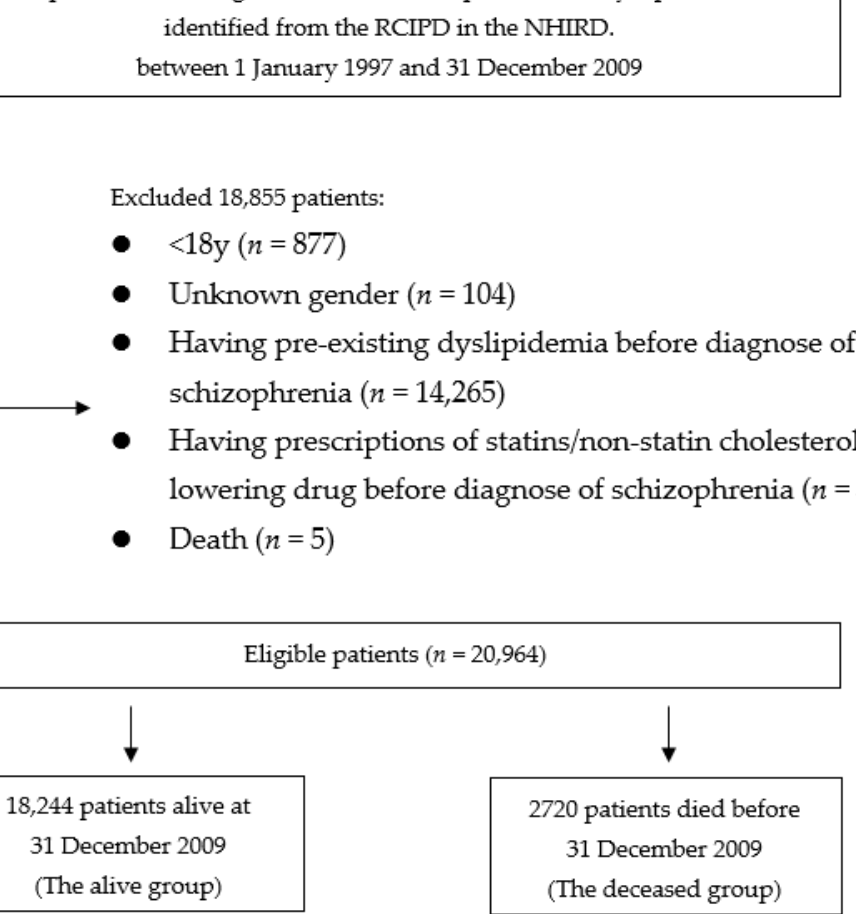
Figure 1. Flowchart of identification and enrolment of the study subjects.